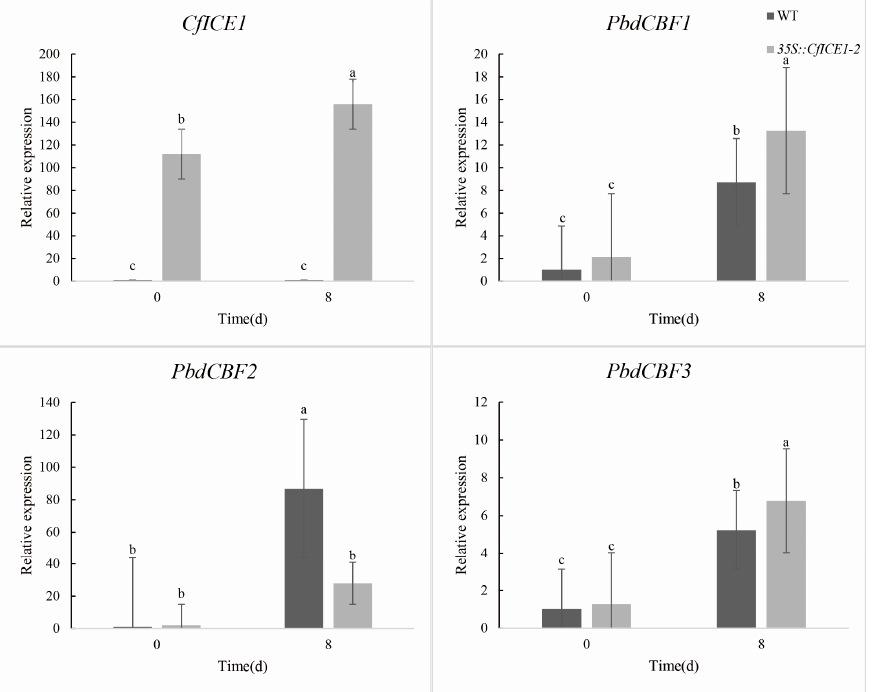
Figure 12. Changes in CfICE1 , PdbCBF1 , PdbCBF2 and PdbCBF3 gene expression under salt stress. Each bar indicates the average ± SD (n = 3), and lowercase letters above each bar indicate significant differences ( p ≤